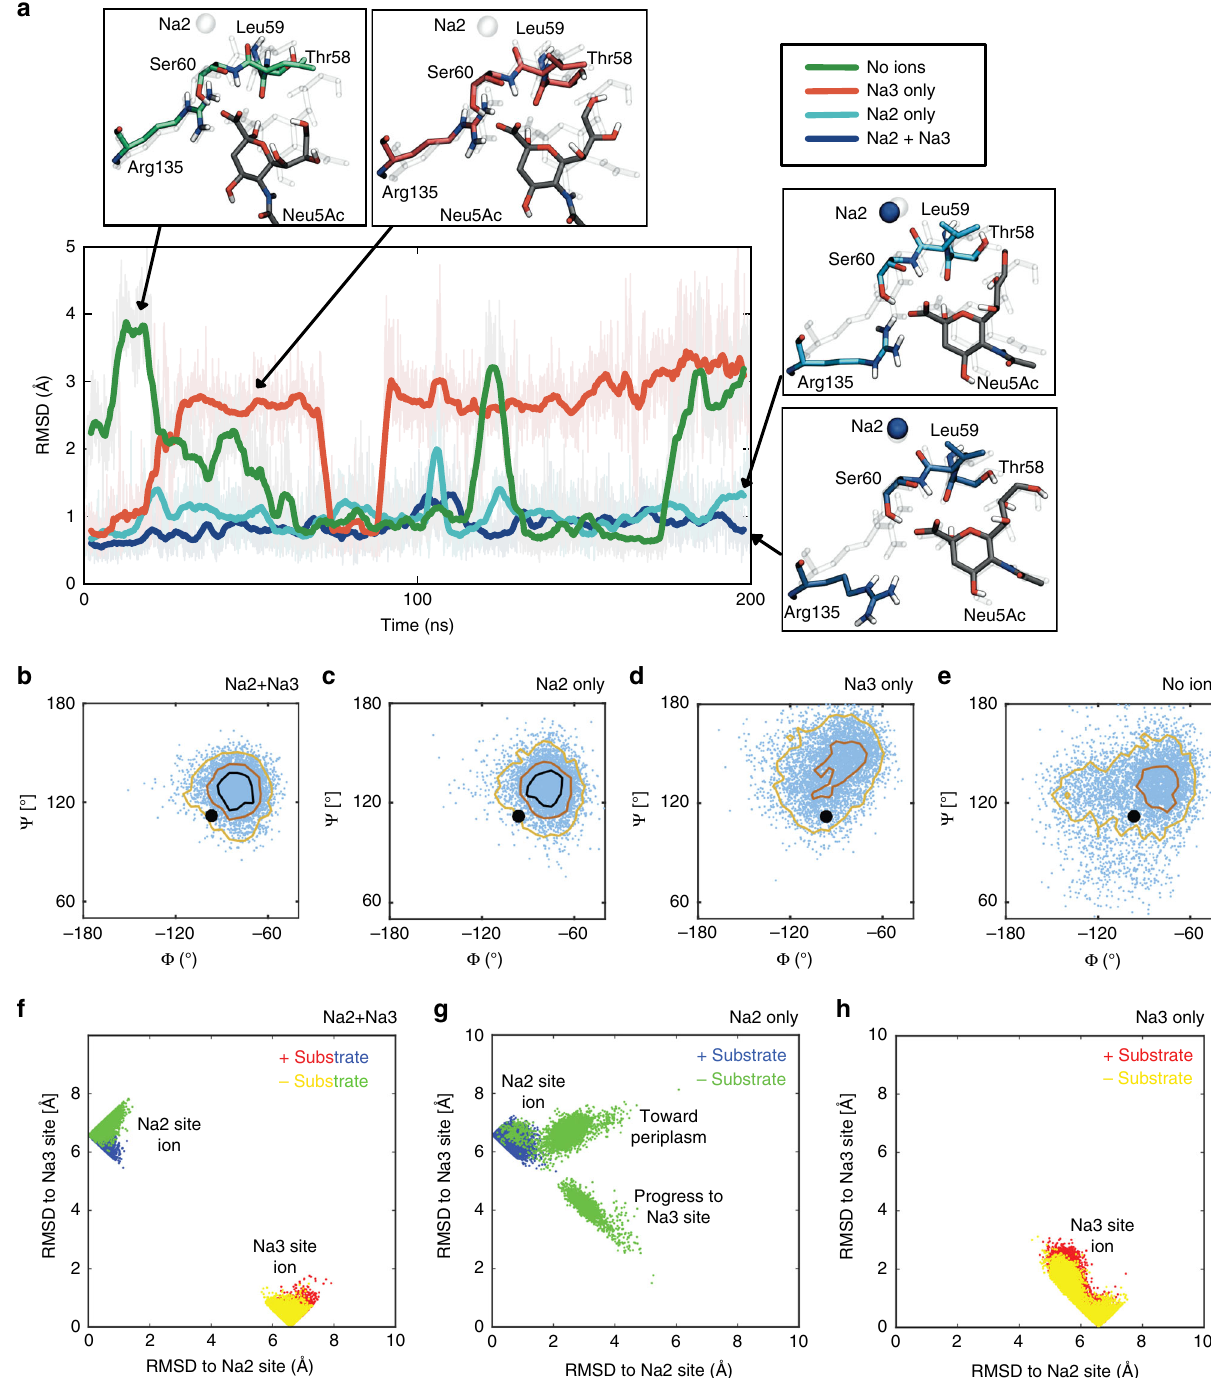
Fig. 6 Molecular dynamics simulations of SiaT. a Heavy-atom RMSD of the substrate with respect to the X-ray structure for four MD simulations with different combinations of Na + ions in the Na2 and Na3 sites (see legend, upper right). Snapshots compare the instantaneous con fi guration of Neu5Ac, Arg135, Na2 (when present), and unwound residues in Tm1 (Thr58, Leu59 and Ser60) with the X-ray structure (ghost). Solid lines are smoothed over an 800 ps window, while the original full data set saved every 40 ps is transparent. b – e Dependence of Leu59 backbone motion on Na + ion occupancy. ϕ and ψ angles for Leu59 from all four simulations with Neu5Ac bound and different combinations of Na + ions in the Na2 and Na3 sites. Both Na2 and Na3 bound ( b ), Na2 bound only ( c ), Na3 bound only ( d ) and no ions bound ( e ). In each panel, the instantaneous angle pairs are plotted every 40 ps over the entire 200 ns simulation (light blue), and the data set is contoured at values of 100 (black), 50 (red) and 10 (yellow). The ϕ and ψ values in the X-ray structure are represented as a black dot. The distributions in panels d and e , which lack an ion in the Na2 site, are so broad that the black high-density contour does not exist. f , g Ion stability in the Na2 and Na3 sites. Simultaneous distance of bound Na + ions to the Na2 site and the Na3 site from 200 ns MD simulations in the presence or absence of Neu5Ac with both Na + ions bound ( f ), only the Na2 ion bound ( g ) and only the Na3 ion bound ( h ). In all panels, every point represents a simulation frame saved every 40 ps, the Na2 ion position is blue (with substrate) or green (without substrate), and the Na3 ion position is red (with Neu5Ac) or yellow (without